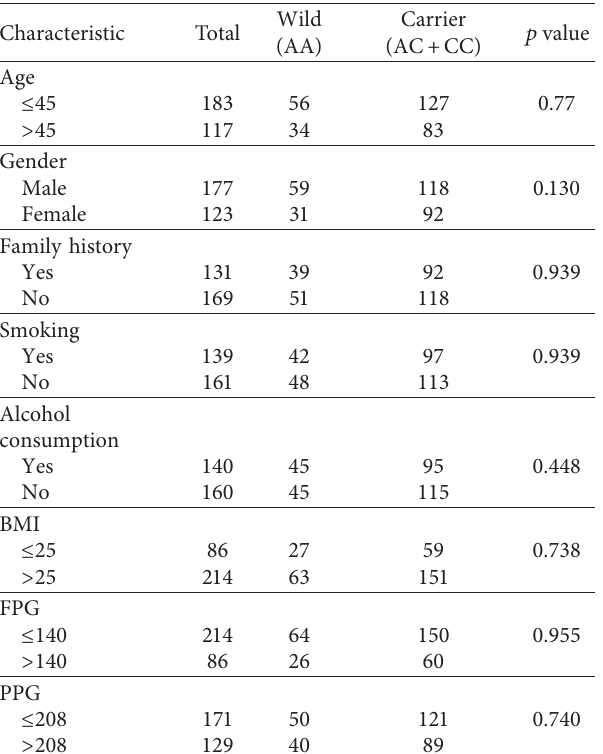
Figure 3: Graphical representation of clinicopathological characteristics of T2DM patients between wild and carrier of a variant allele of the KCNJ11 gene. Table 6: Clinicopathological characteristics of T2DM patients between wild and carrier of a variant allele of the KCNQ1